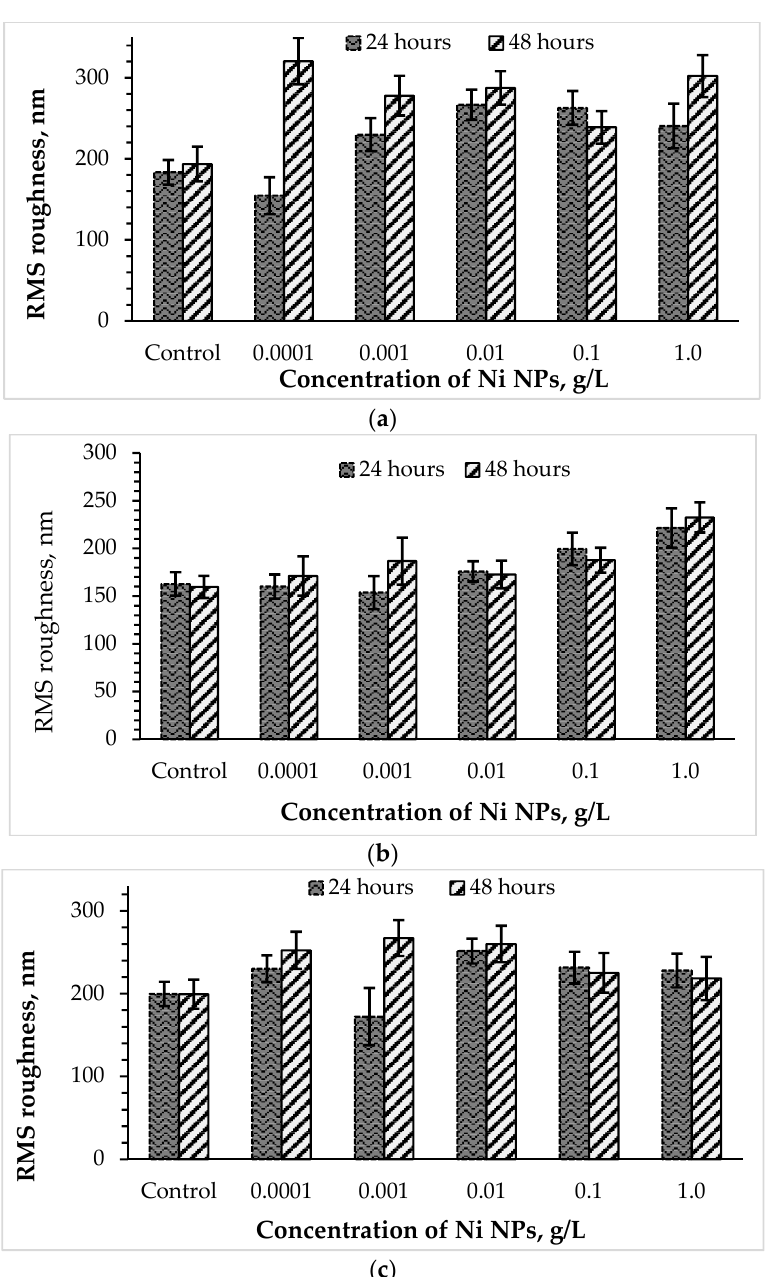
Figure 5. Changes in the surface roughness of R. opacus IEGM 263 ( a ), R. rhodochrous IEGM 1363 ( b ) and R. ruber IEGM 231 ( c ) cells incubated with different concentrations of Ni NPs. The cells of R. opacus IEGM 263, initially having a smoother surface, when incubated with lower (0.0001–0.01 g/L) concentrations of Ni NPs, showed relatively stable values of RMS roughness, slightly deviating from the control figures. A further increase in the nanoparticle concentration to 0.1–1.0 g/L led to maximum changes in the R. opacus microre- lief (by 37 and 42% after 24 and 48 h, respectively). The RMS roughness of R. rhodochrous IEGM 1363 cells increased more significantly than R. ruber IEGM 231 and R. opacus IEGM 263, especially during 48-h incubation with Ni NPs, thus indicating a stronger damaging ef- fect of the nanometal on this strain. The maximum RMS roughness values of R. rhodochrous IEGM 1363 cells were observed in the presence of 0.0001 and 1.0 g/L of Ni NPs, suggesting the absence of a strict concentration dependence of cell wall damage during prolonged exposure to the